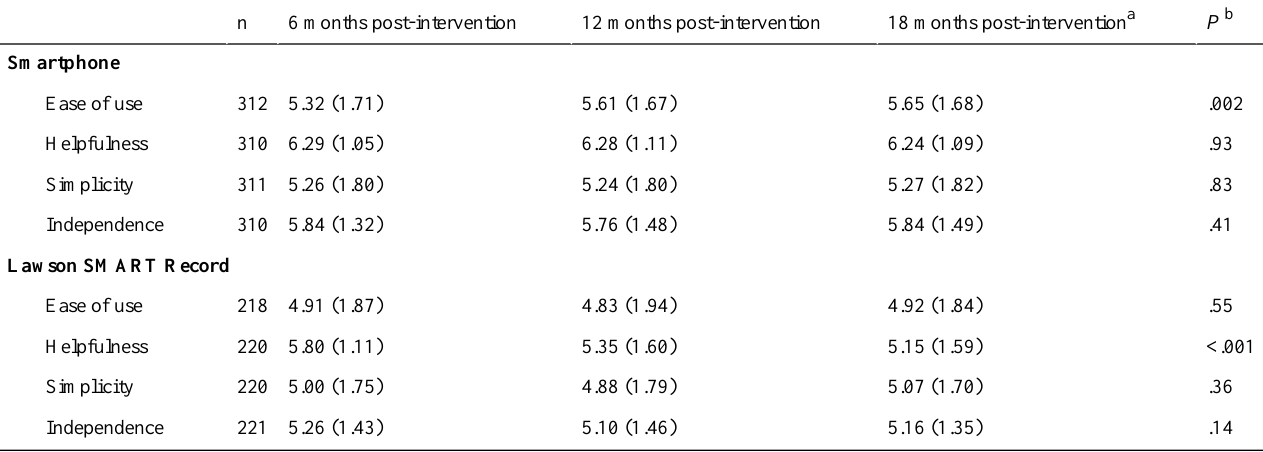
Table 2. Client perception scores regarding ease of use, helpfulness, simplicity, and provision of independence of the smartphone and Lawson SMART Record over